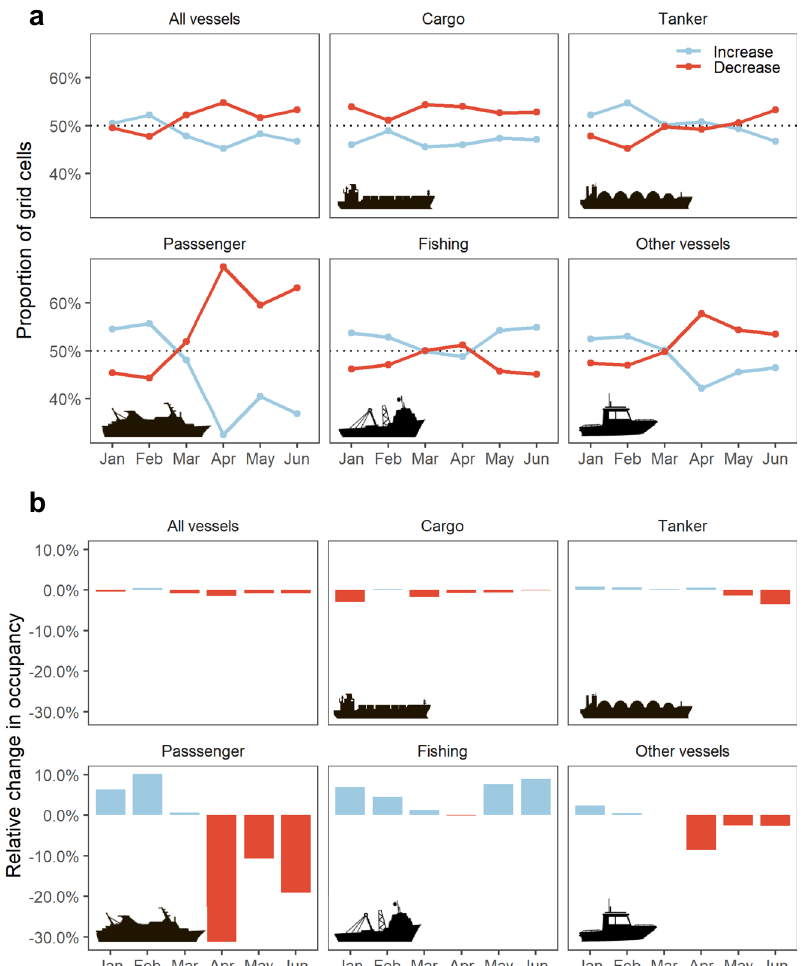
Fig. 4 Global changes in marine traf fi c during COVID-19. a Changes in traf fi c density represented as a proportion of grid cells with increases and decreases per month and vessel category. b Changes in occupancy estimates, re fl ecting gains and reductions of the extent used by each vessel category per month. All estimates in ( a ) and ( b ) are based on a global grid of 0.25 degrees resolution, comparing between equivalent months (January – June)